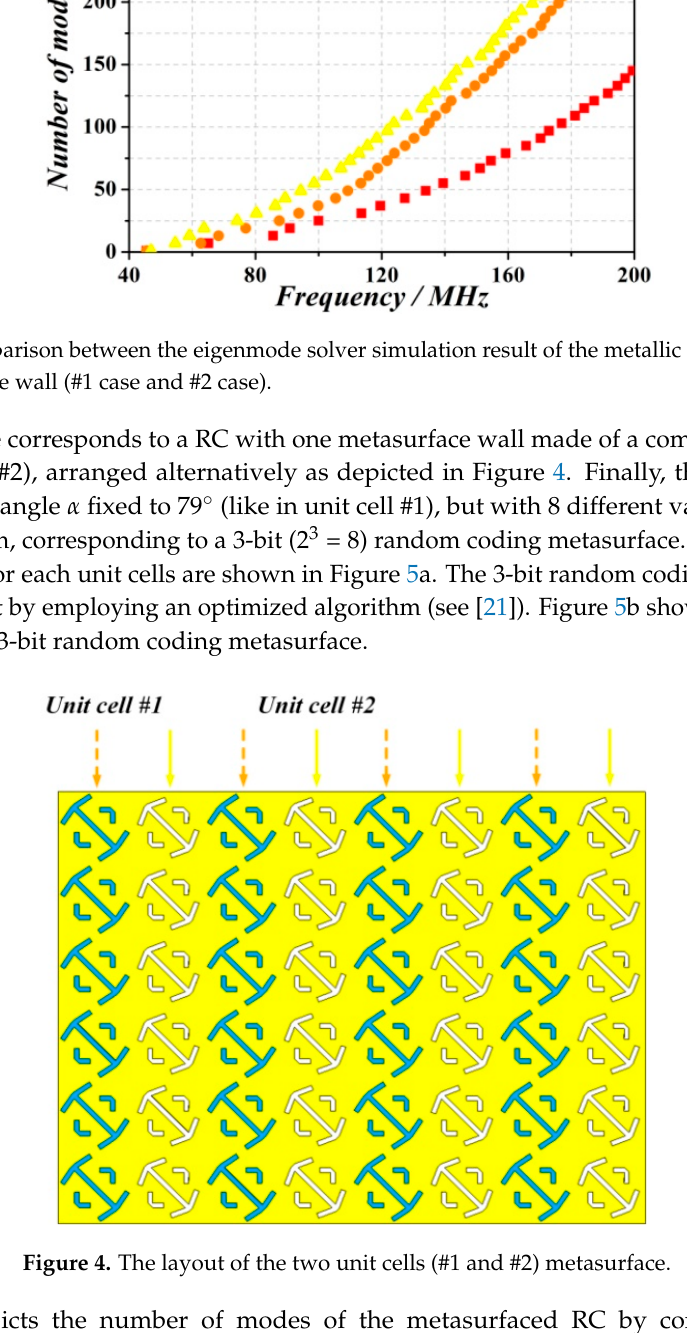
Figure 4. The layout of the two unit cells (#1 and #2) metasurface.